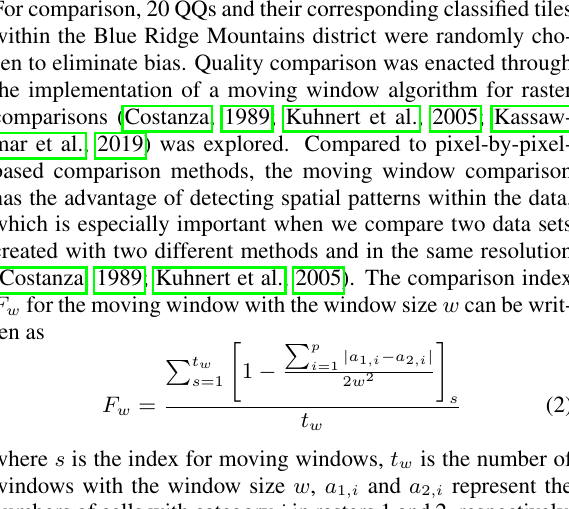
Figure 3. (a) Elapsed time as the number of tiles processed grows for each of the six districts for each method. Both CanoClass ET and RF plot all the six districts in the same black and green colors, respectively. Feature Analyst 1 plots the three districts produced by the Windows system 1 in red while Feature Analyst 2 plots the other three districts by the Windows system 2 in blue. The three blue outlier points indicate that additional Feature Analyst sessions were needed to complete those districts because of unexpected circumstances such as weekly maintenance reboots. The 415 th tile for the Barrier Island Sequence district, and the 648 th and 649 th tiles for the Vidalia Uplands district were run in separate Feature Analyst sessions. (b) The three outliers were excluded from the box plot for Feature Analyst